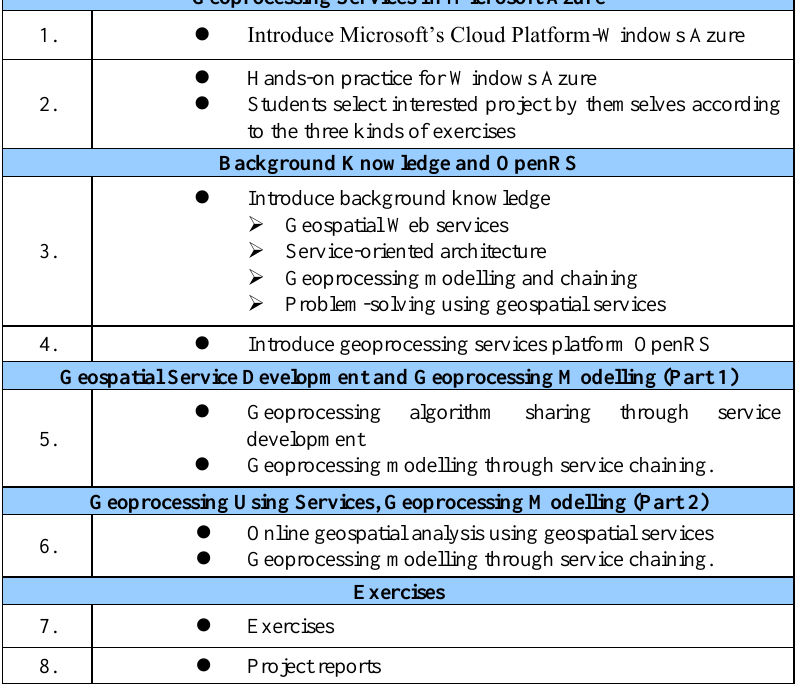
Table 1. Syllabus of the